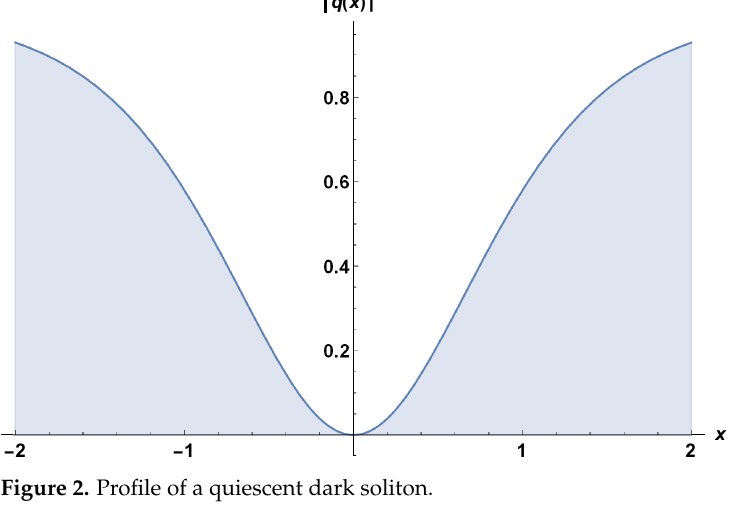
Figure 2. Profile of a quiescent dark